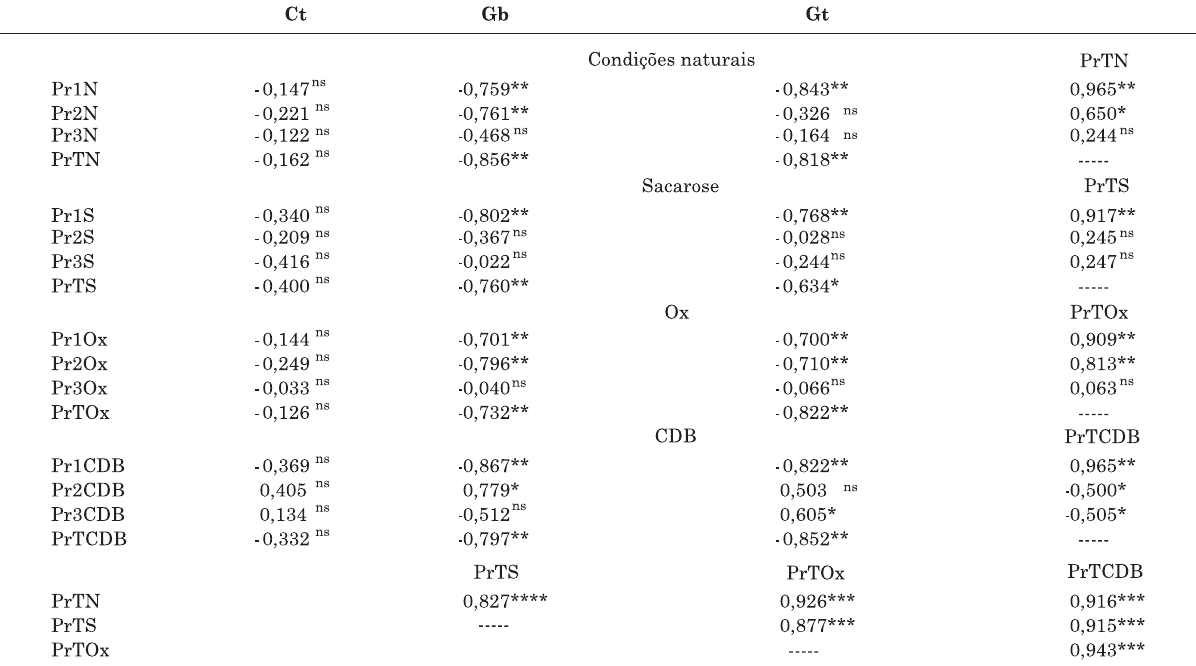
Quadro 3. Coeficientes de correlação linear simples entre o teor de P da primeira extração (Pr1), da segunda extração (Pr2), da terceira extração (Pr3) e do somatório do P das dez extrações com resina de troca aniônica (PrT) (mg kg -1 ), e teores de caulinita (Ct), de gibbsita (Gb) e de goethita (Gt) na fração